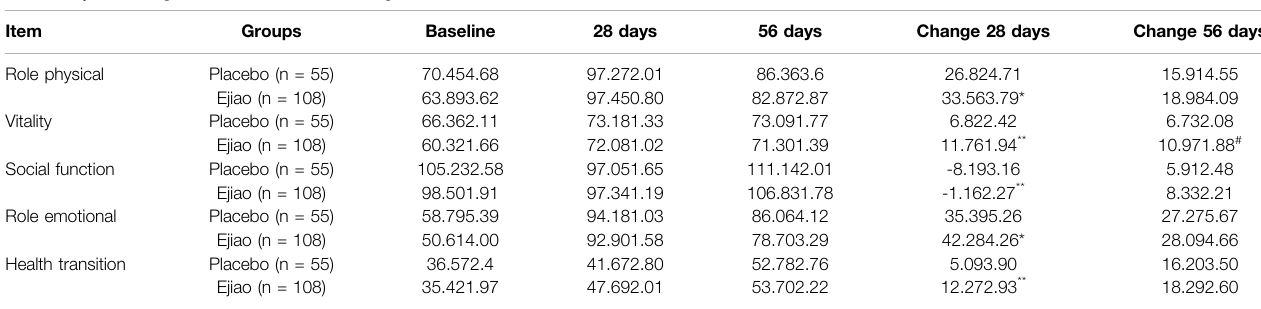
TABLE 4 | The changes of SF-36 subscales during the 24